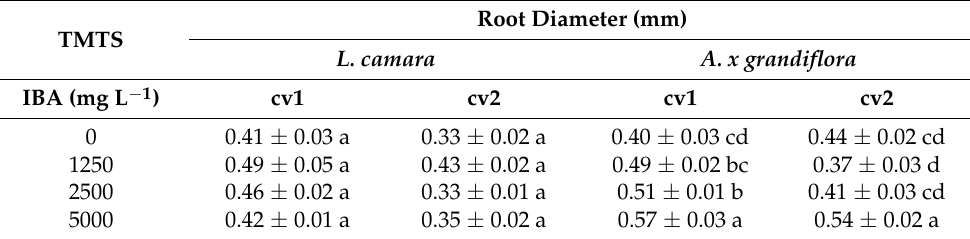
Table 2. Root diameter in wild sage and glossy abelia at 50 DAC, according to IBA concentration and cultivar.